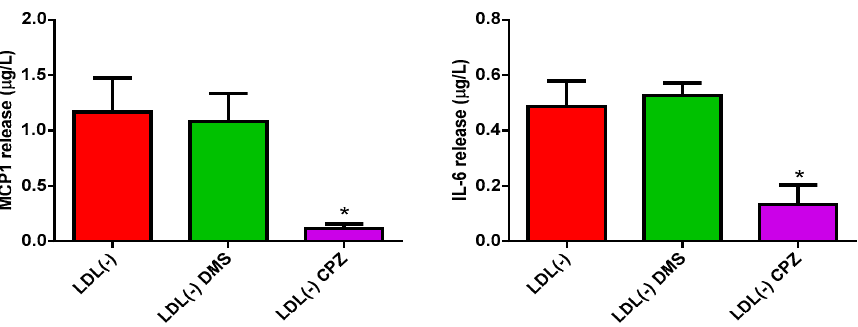
Figure 2. MCP1 and interleukin-6 (IL-6) release promoted by LDL( − ) in human monocytes in the presence or absence of DMS and chlorpromazine CPZ. Monocytes were incubated with LDL( − ) (60 mg apoB/L) in the absence (red bars) or presence of DMS (green bars) and CPZ (purple bars), both at 10 µM. After 20 hours of incubation, cytokine release was measured by ELISA. Results are expressed as mean ± SD ( n = 5), * vs. absence of inhibitor, p < 0.05.